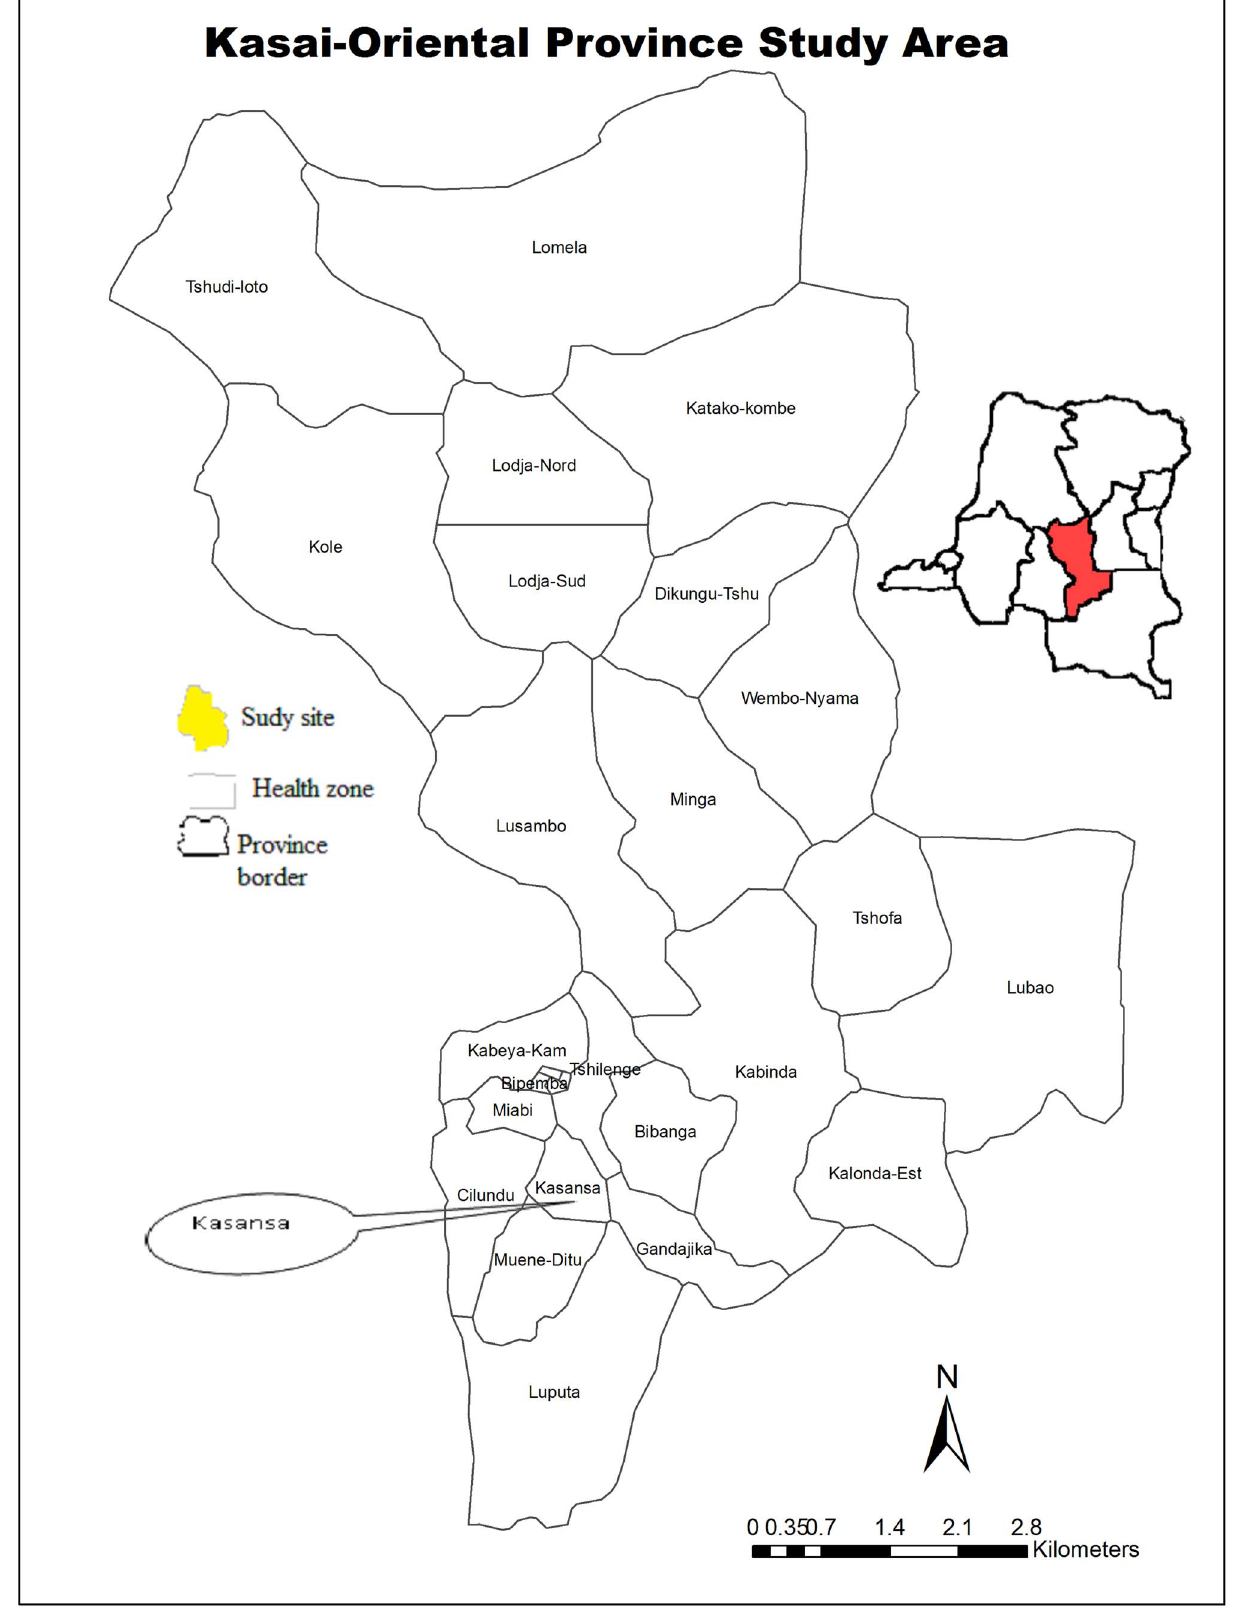
Fig. 1. Democratic Republic of the Congo, the province of Kasaı¨ Oriental is highlighted. doi:10.1371/journal.pntd.0003387.g001 PLOS Neglected Tropical Diseases | www.plosntds.org